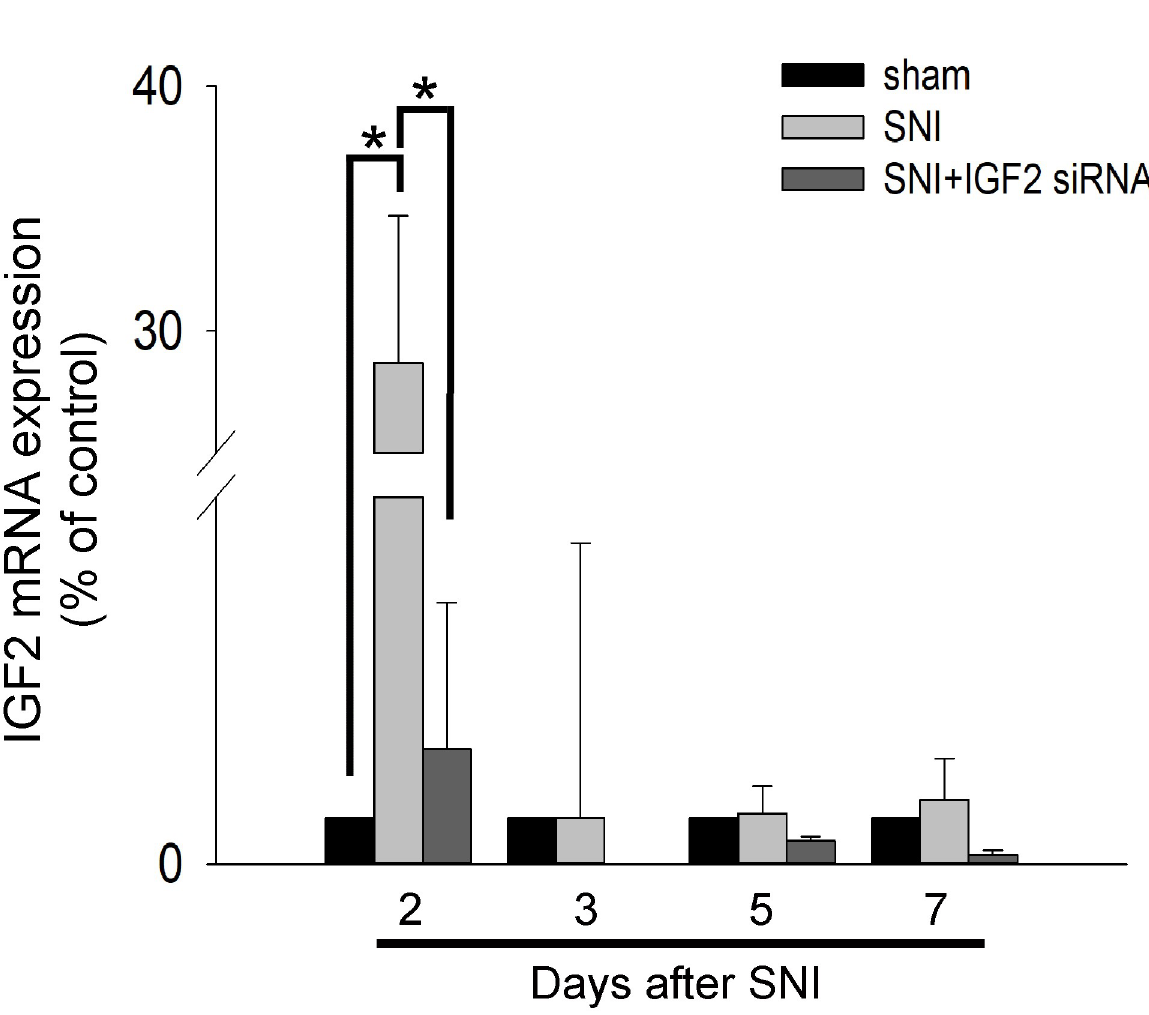
Fig 3. Intrathecal injection of IGF2 siRNA decreases IGF2 mRNA expression in the spinal cord. On Days 2, 3, 5, and 7, the rats are sacrificed, and the total RNA of the spinal cord is extracted by homogenizing spinal cord samples (L4–6). Data are presented as mean ± standard deviation (n = 3 per group). Black bar, sham group; gray bar, SNI group; dark bar, SNI + siRNA IGF2 group. SNI, spared nerve injury; siRNA, small- interfering RNA; IGF2, insulin-like growth factor-2.